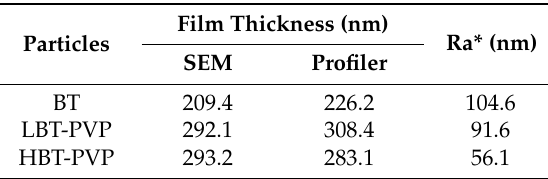
Figure 8. Stylus profiles of BT, LBT-PVP, and HBT-PVP films coated on Si substrates measured by stylus profiler. Table 3. Properties of BT, LBT-PVP, and HBT-PVP thin films coated on Si substrates. Particle concentration in the EtOH coating slurry was 5 wt % (Ra*: average